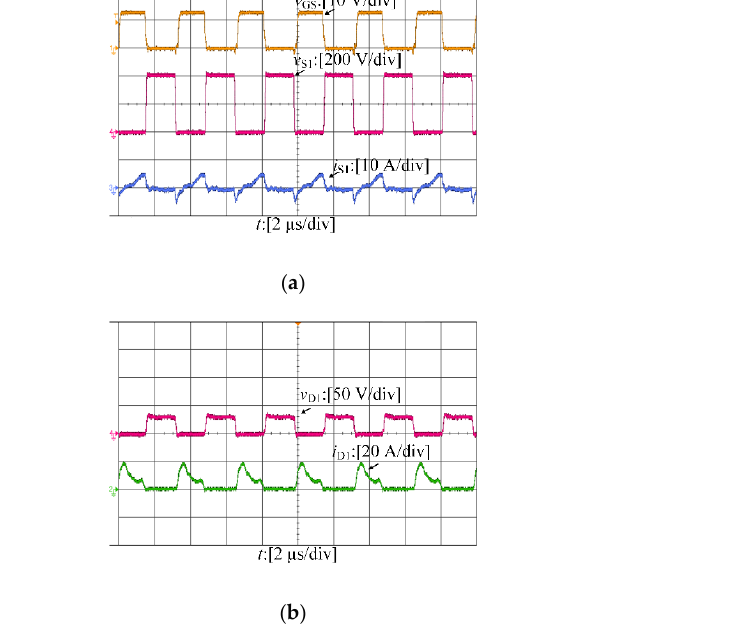
Figure 17. Experimental results at 30% condition ( a ) waveforms of power switch S 1 , ( b ) waveforms of diode D 1 .